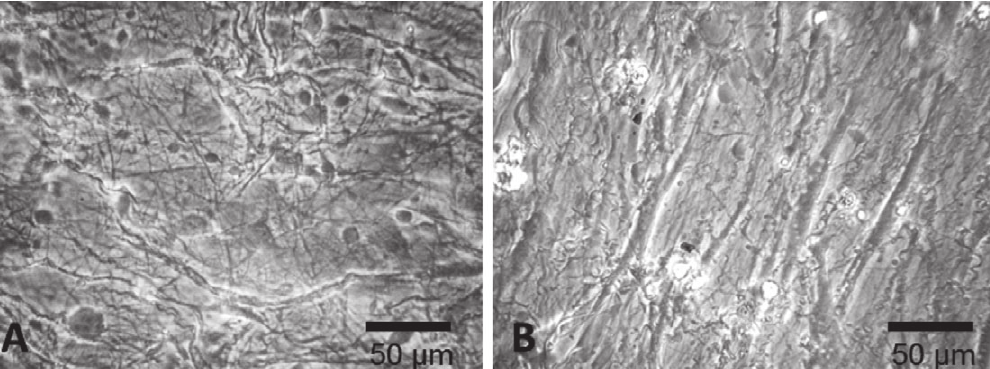
Figure 1 Cross sections of PCL nanofiber scaffolds with seeded primary myoblasts. (A) Unstructured fiber orientation; (B) aligned fiber